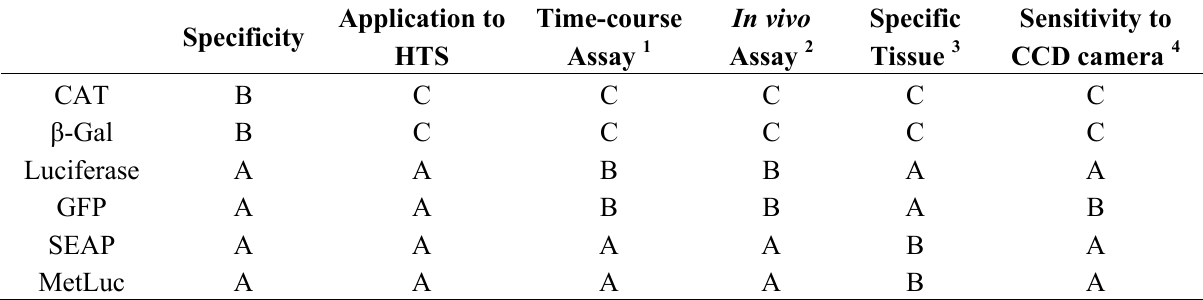
Table 1. Properties of reporter